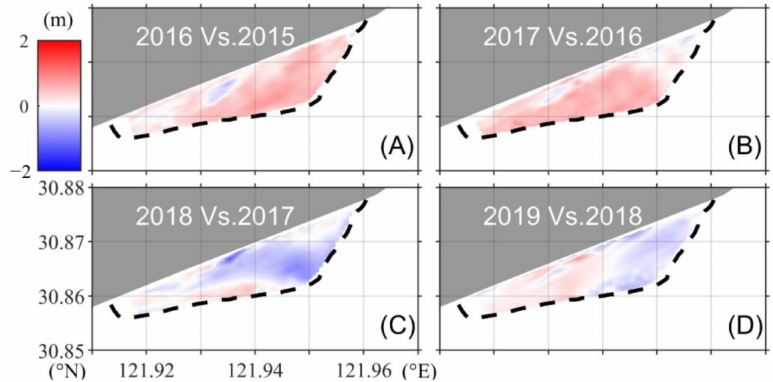
Figure 12. ( A – D ) are the annual monitored changes in the topography from 2015 to 2019. The black dashed line marks the approximate location of the waterline corresponding to the lowest tidal